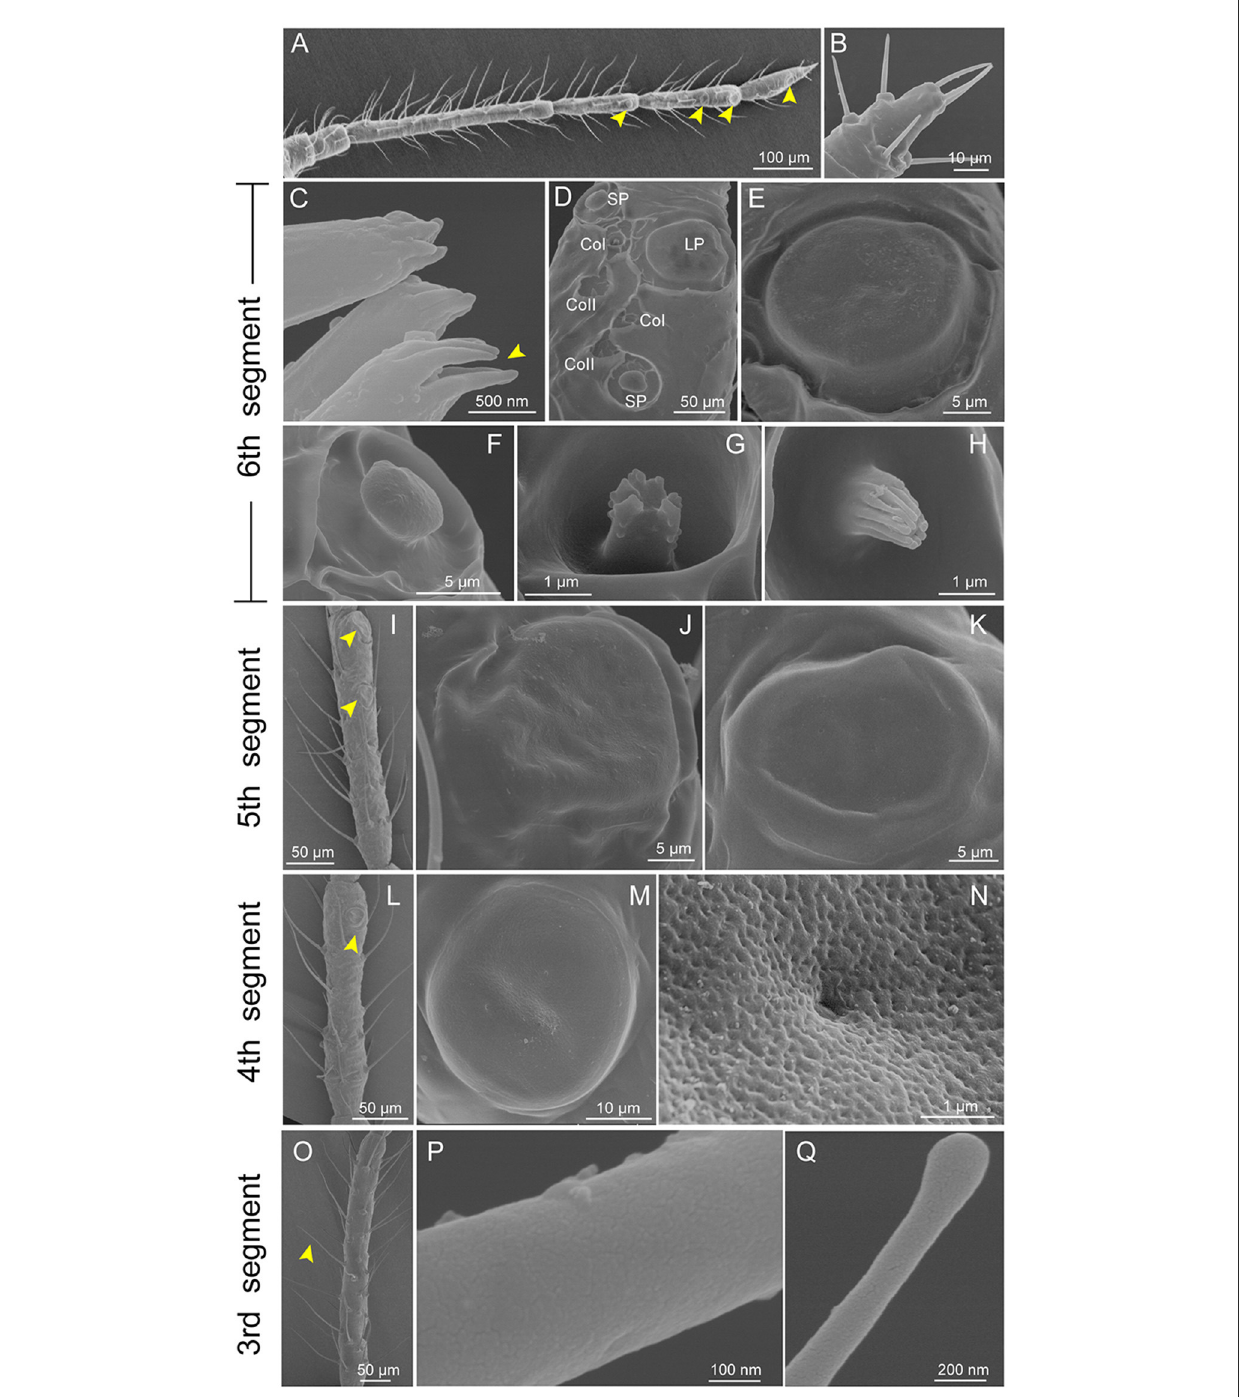
FIGURE2 Scanning electron micrographs of Cinara cedri antenna. (A) A whole view of the antenna shows the primary rhinaria (yellow arrowheads). (B) Type II trichoid sensilla at the distal end of the antennae. (C) Type II trichoid sensilla with fissure-like structures on the surface with no grooves and had a pore on the top center (yellow arrowheads). (D) The primary rhinarium on the 6th segment consists of one large placoid sensillum (LP), two small placoid sensilla (SP), and four coeloconic sensilla (2 CoI and 2 CoII). (E–H) An enlarged view of the LP (E) , SP (F) , CoI pegs (G) , and CoII pegs (H) on the 6th segment. (I) A whole view of the primary rhinarium (yellow arrowheads) on the 5th segment consists of two large placoid sensilla (LP5I and LP5II). (J, K) An enlarged view of LP5I and LP5II. (L) A whole view of the large placoid sensillum (yellow arrowhead) on the 4th segment (LP4). (M) An enlarged view of the LP4. (N) A porous surface of LP4. (O) Type I trichoid sensilla (arrowhead) located on the 3rd segment. (P, Q) Type I trichoid sensilla showing a smooth surface (P) and a swollen tip with no pore (Q)